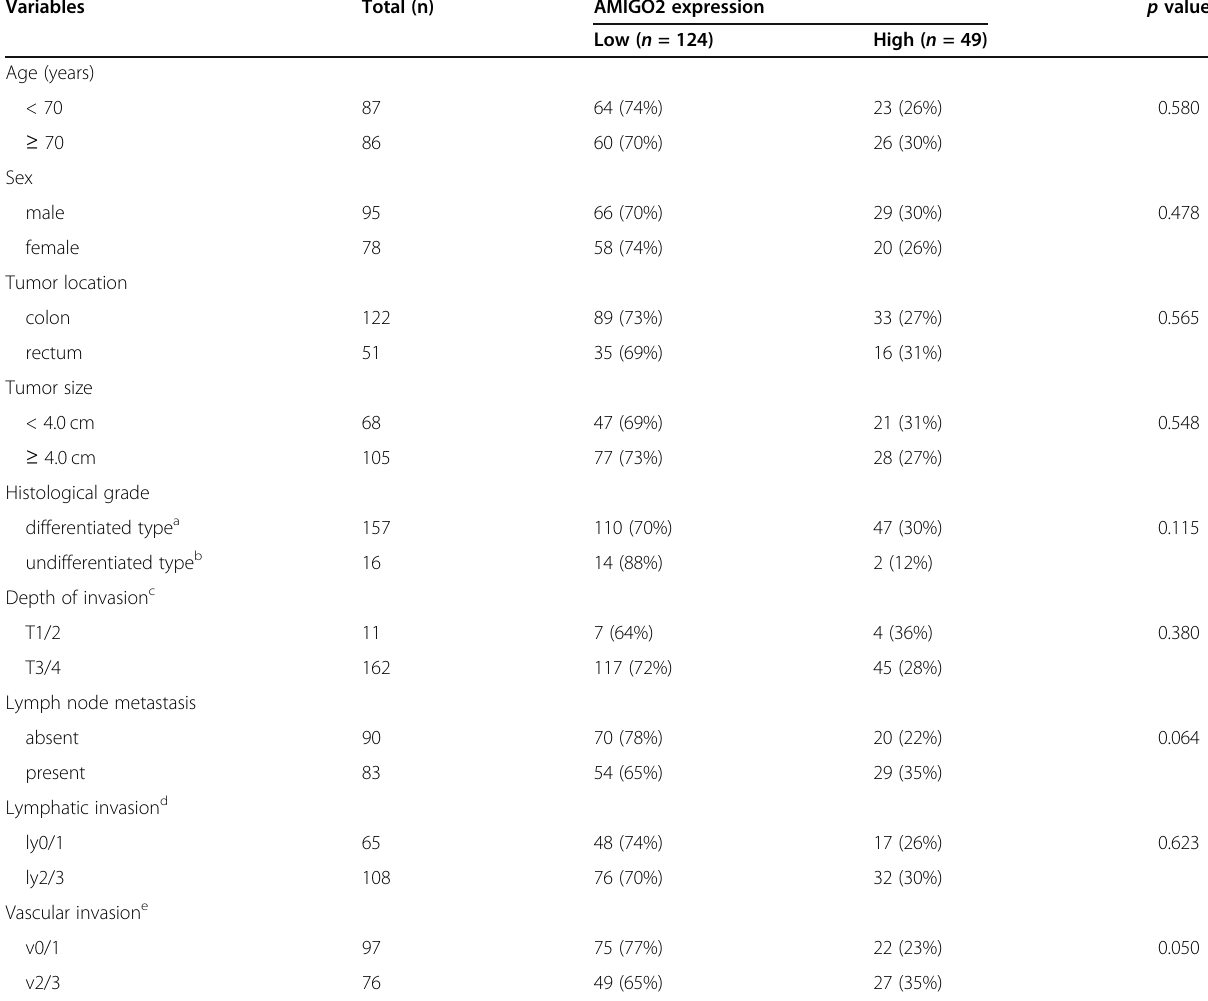
Table 1 AMIGO2 expression and clinicopathological factors affecting overall survival rate in 173 CRC patients